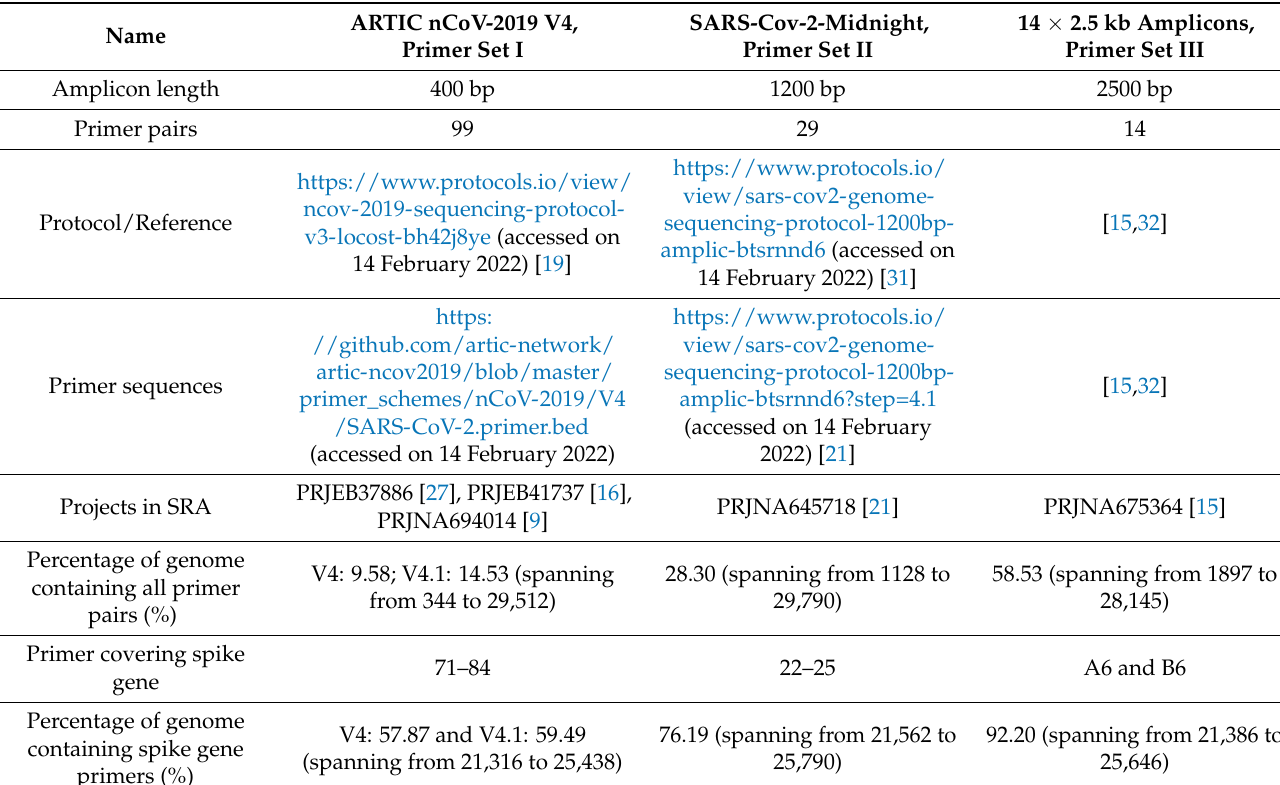
Table 1. Basic descriptions and primer evaluations of amplicon tiling methods for SARS-CoV-2